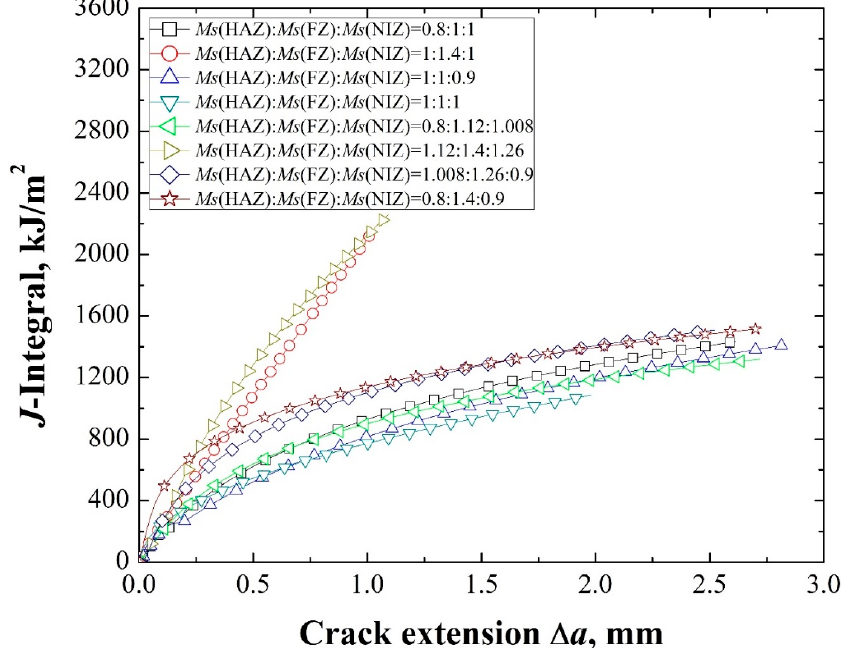
Figure 9. The J – R curves of the DMWJ under different strength mismatches.